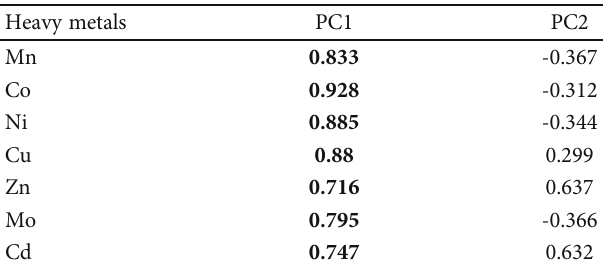
Table 7: Results of principal component analyses for concentrations of heavy metals. Bold values represent strong positive loading, which marked loadings > 0 : 7